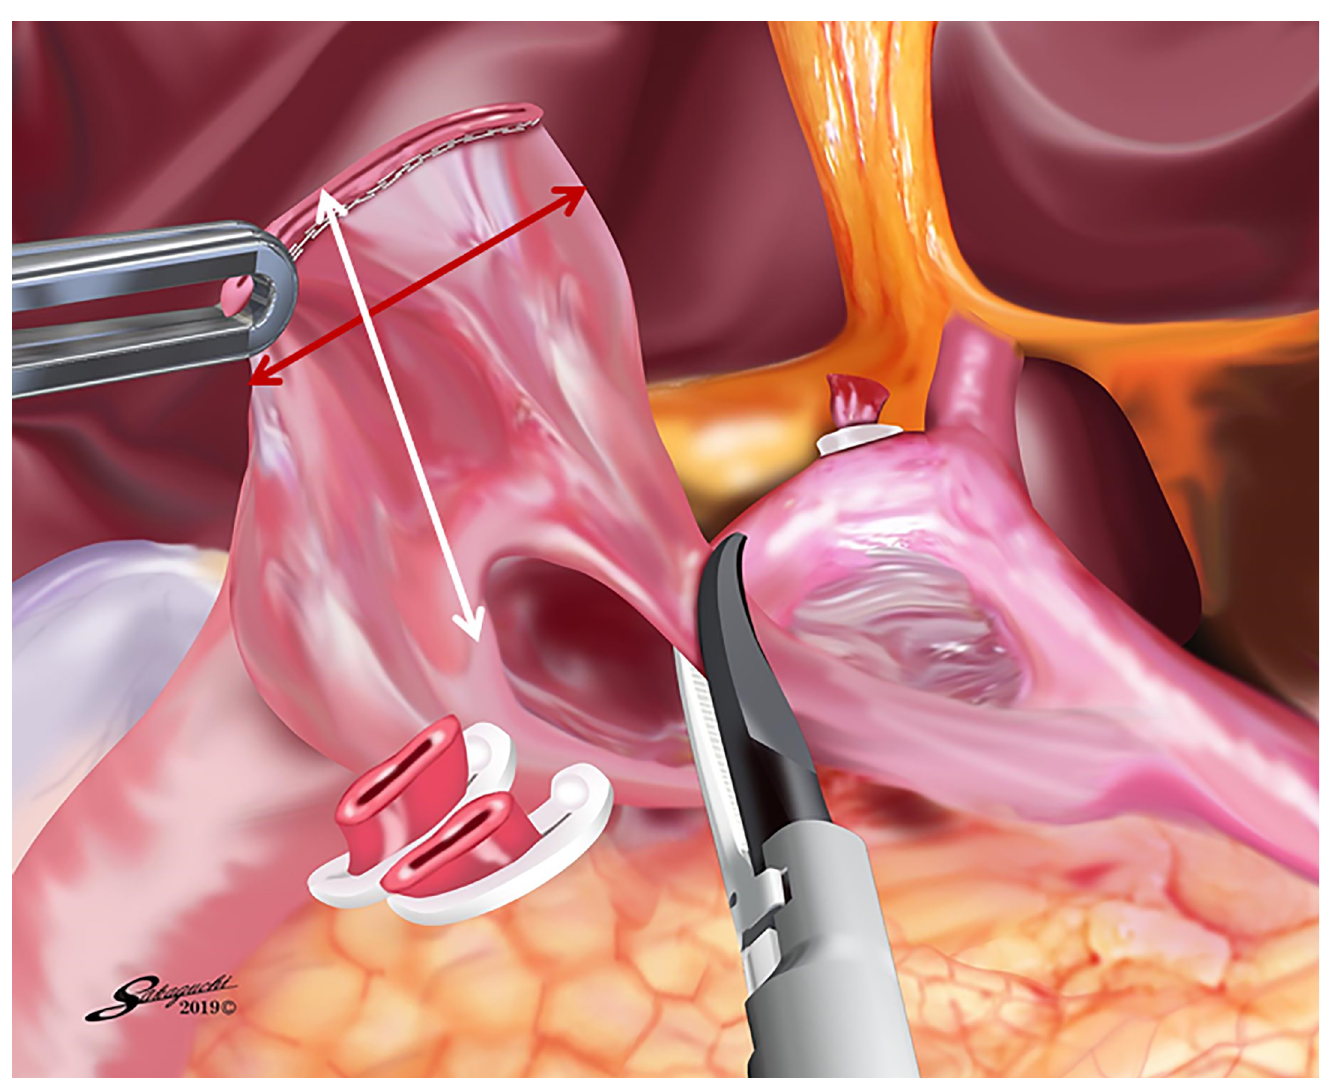
Fig 3. Creation of a space around the posterior wall of the duodenal bulb. A sufficient space for stapler insertion around the posterior wall of the duodenal bulb is created by dissecting the superior duodenal vessels (red line: diameter of the duodenal bulb, white line: length of the duodenal bulb).